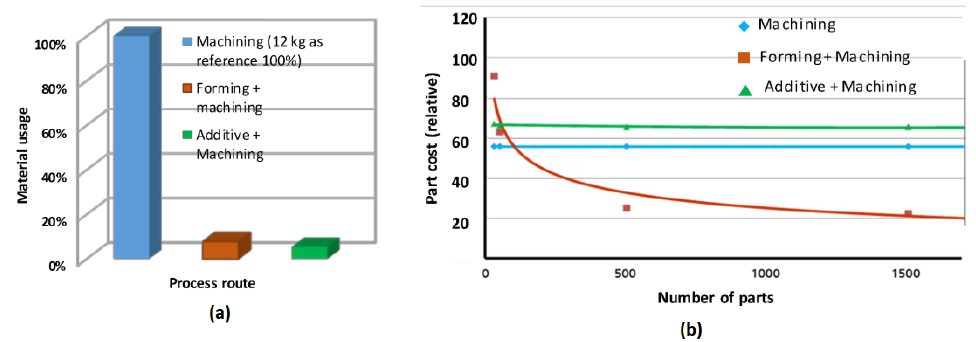
Figure 1. ( a ) Material usage results; ( b ) cost results, reproduced from [59], with the permission from IOP Publishing, 2018.